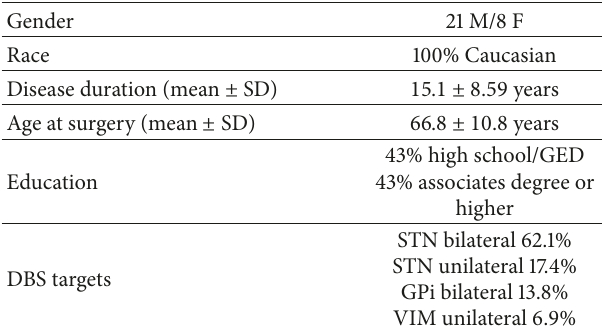
Table 1: Patient demographics and clinical